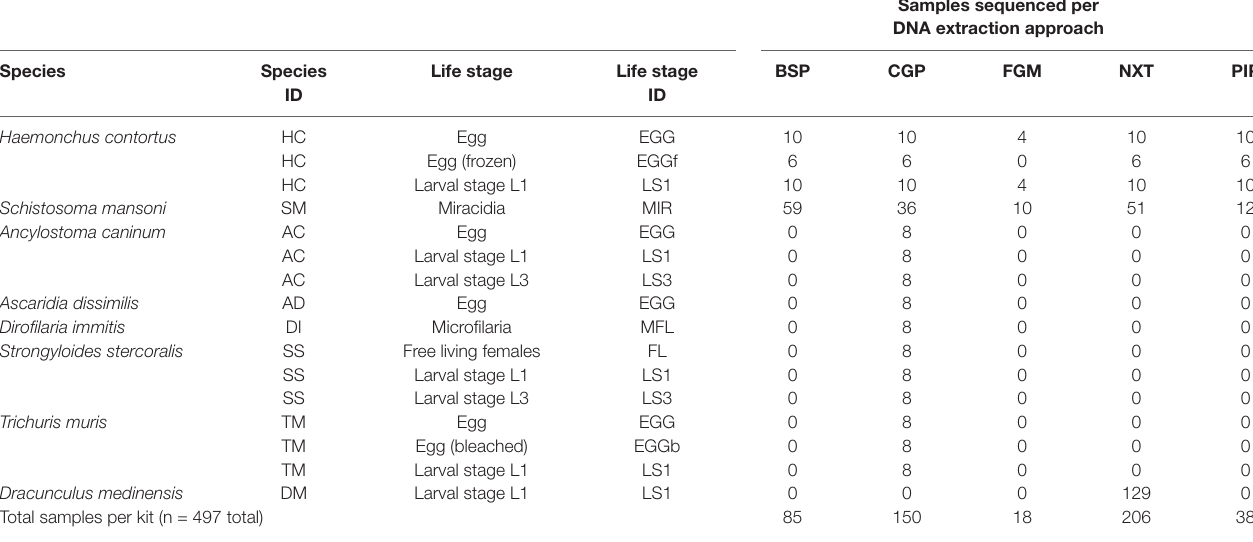
TABLE 1 | Summary of the species, life stages, and conditions tested using one or more of the DNA extraction approaches followed by whole-genome sequencing.